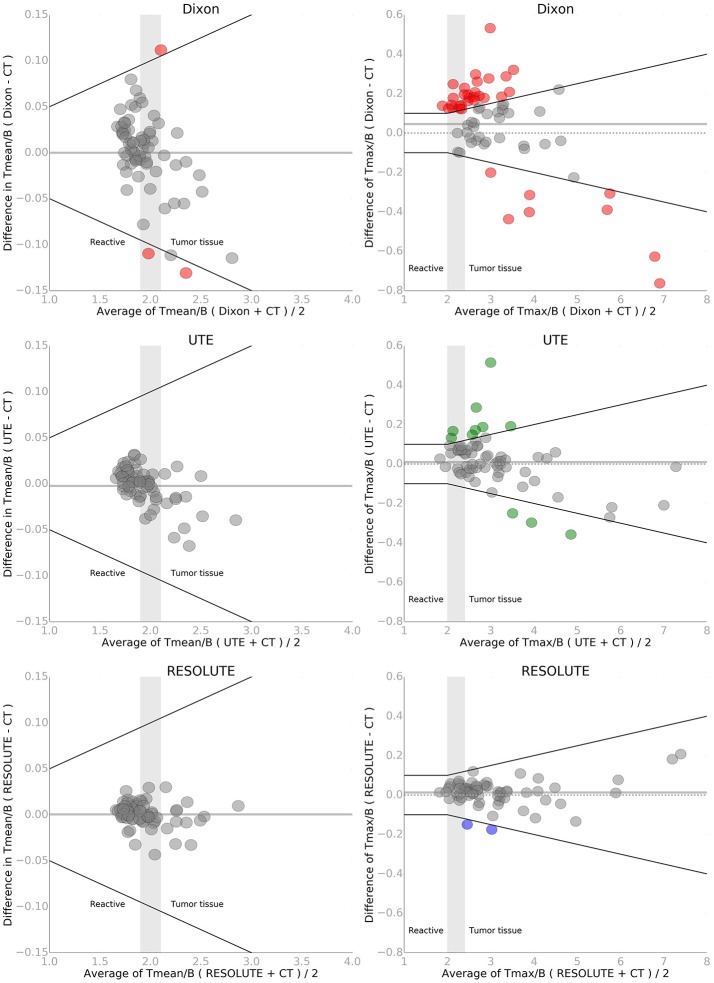
Bland-Altman plot of TMEAN/B (left) and TMAX/B (right) for each of the three MR-AC methods against the reference standard CT-AC. To simulate the clinical impact of the metrics in evaluating reactive changes vs. tumor recurrence 3 intervals have been labeled along the x-axis. The gray shaded areas define an interval of ambiguity. The black lines indicate the acceptance criteria of TMEAN/B of ±0.05 or 5% and TMAX/B of ±0.1 or 5%, respectively. Points that exceed the criteria have been colored. Note the difference on the axes. The solid gray line indicates the mean value.